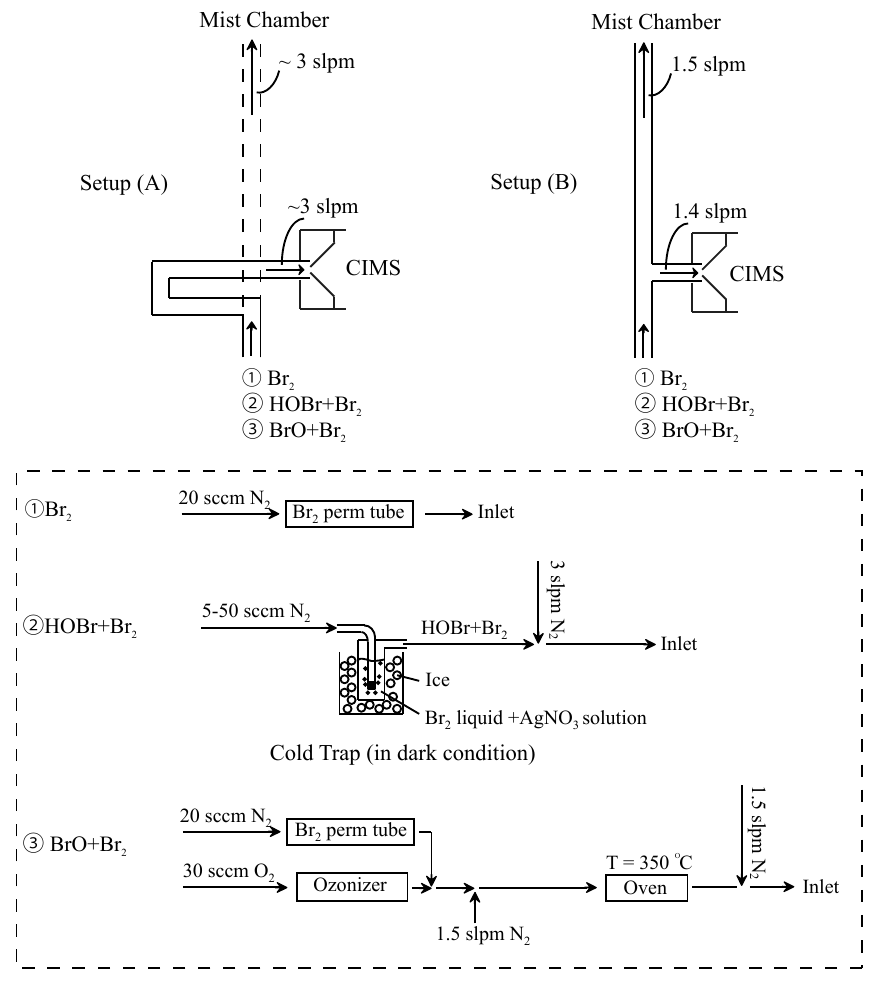
Fig. 1. Inlet configurations and Br 2 , HOBr and BrO sources for soluble bromide characterization. In setup (A), the solid inlet line presents the sampling inlet connecting to the CIMS and the dashed inlet line denotes the same inlet line connecting to the